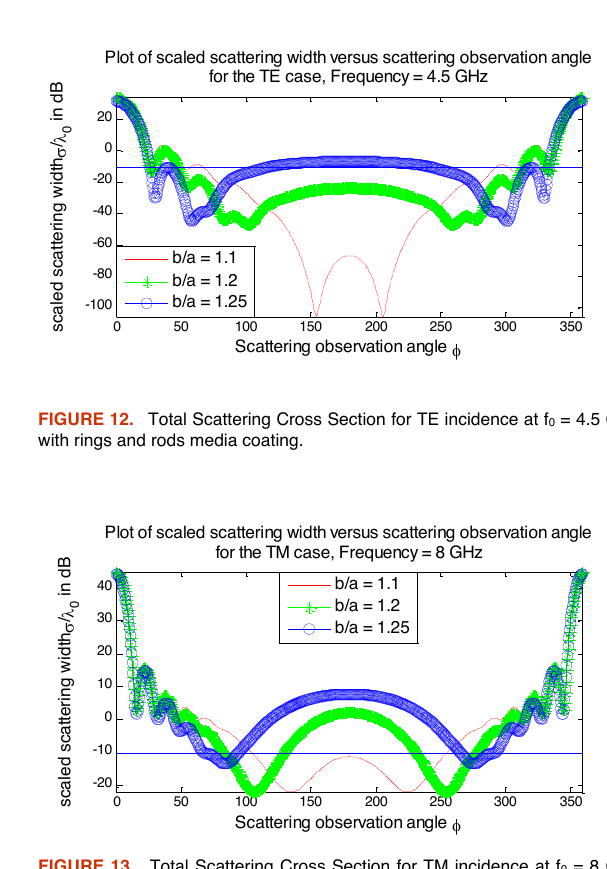
FIGURE 13. Total Scattering Cross Section for TM incidence at f 0 = 8 GHz with rings and rods media coating.